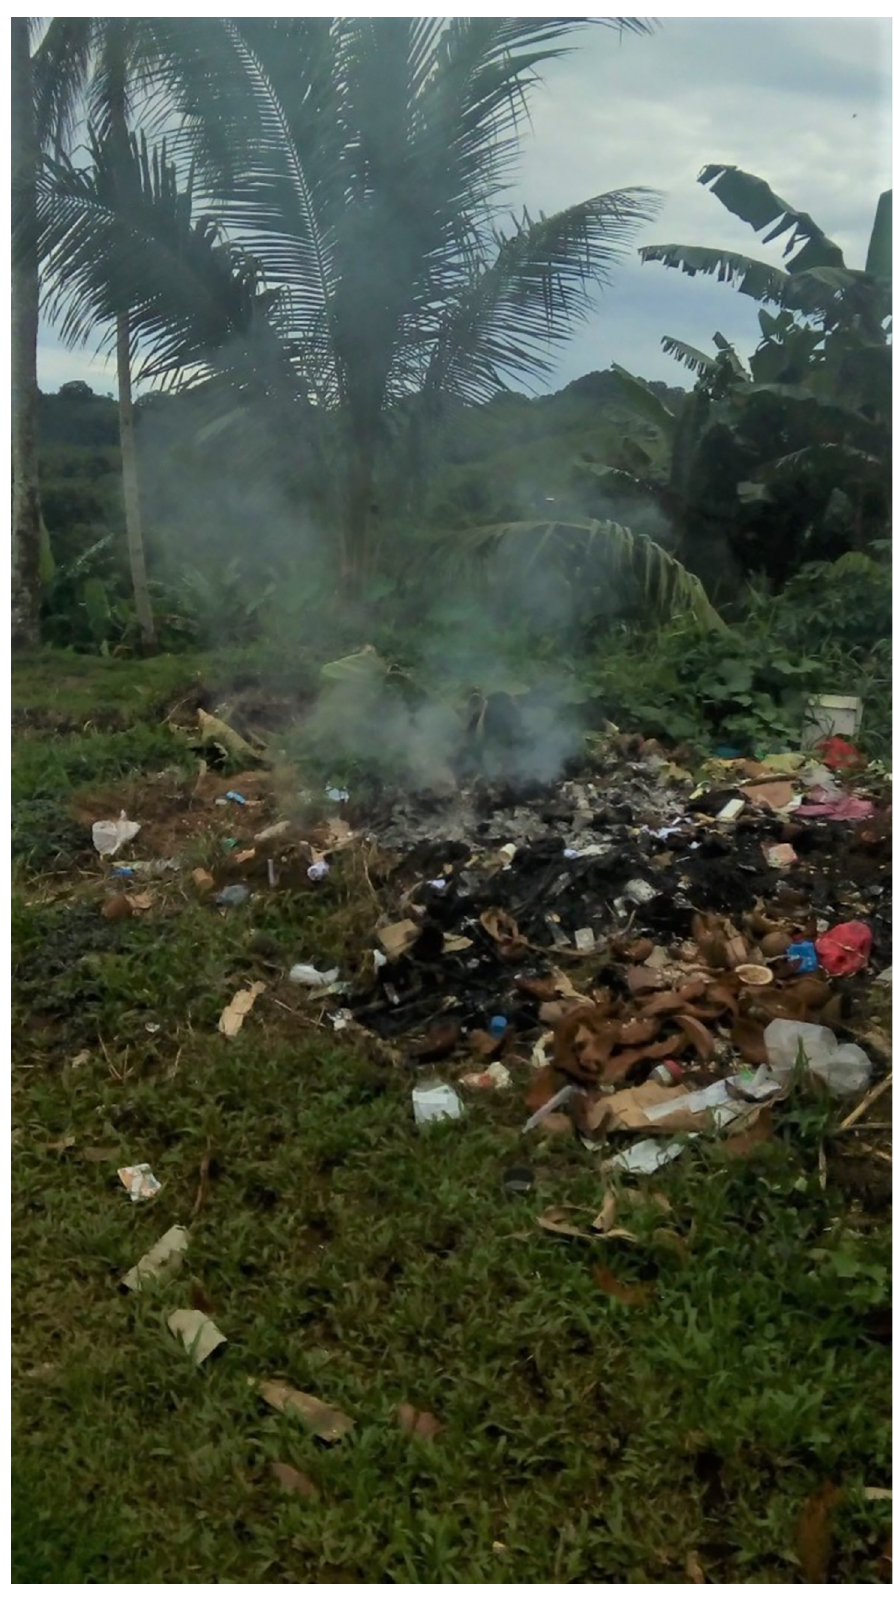
Fig 6. F2P3 (Polluted